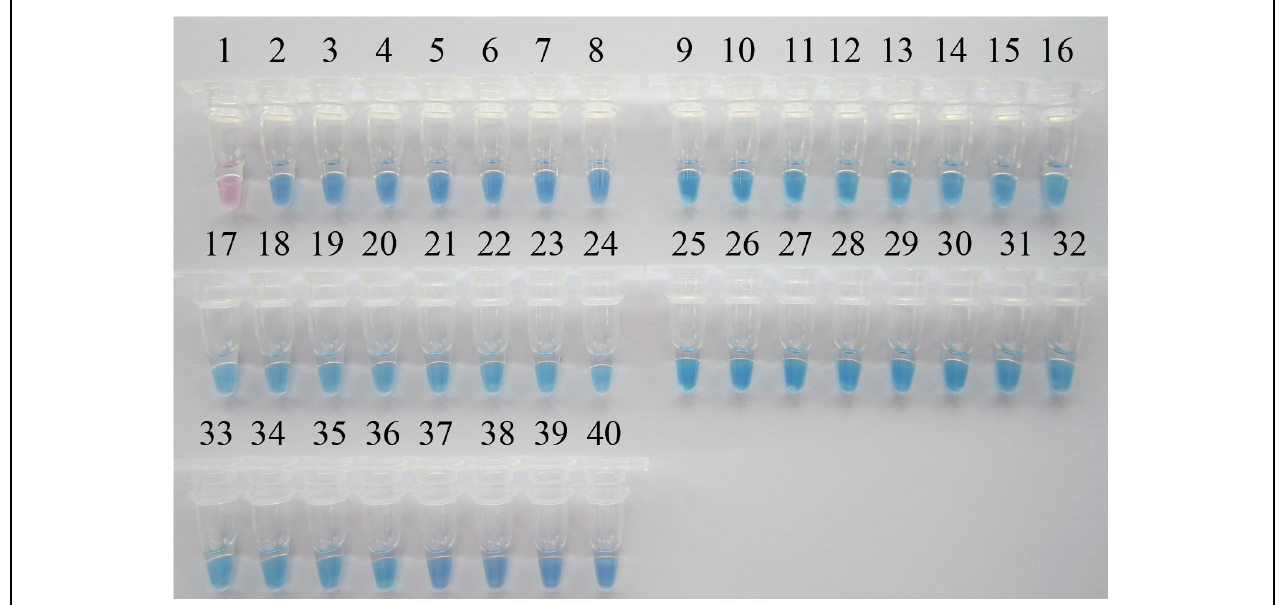
FIGURE 5 | Visual PSR detection of P. aeruginosa isolates from clinical samples. The results were visualized by the addition of 1 μ l HNB solution to the 25- μ l reaction mix before the PSR reaction. 1, Negative control (double-distilled water); 2, positive control ( P. aeruginosa ATCC 15442); 3, positive control ( P. aeruginosa CMCC 10539); 4, P. aeruginosa SY-79; 5, P. aeruginosa SY-23; 6, P. aeruginosa SY-33; 7, P. aeruginosa SY-11; 8, P. aeruginosa SY-18; 9, P. aeruginosa SY-29; 10, P. aeruginosa SY-69; 11, P. aeruginosa SY-34; 12, P. aeruginosa SY-05; 13, P. aeruginosa SY-24; 14, P. aeruginosa SY-95; 15, P. aeruginosa SY-63; 16, P. aeruginosa SY-59; 17, P. aeruginosa SQ-25; 18, P. aeruginosa SQ-129; 19, P. aeruginosa SQ-09; 20, P. aeruginosa SQ-01; 21, P. aeruginosa SQ-23; 22, P. aeruginosa SQ-29; 23, P. aeruginosa SQ-37; 24, P. aeruginosa SQ-14; 25, P. aeruginosa SQ-73; 26, P. aeruginosa WJ-44; 27, P. aeruginosa WJ-66; 28, P. aeruginosa WJ-98;